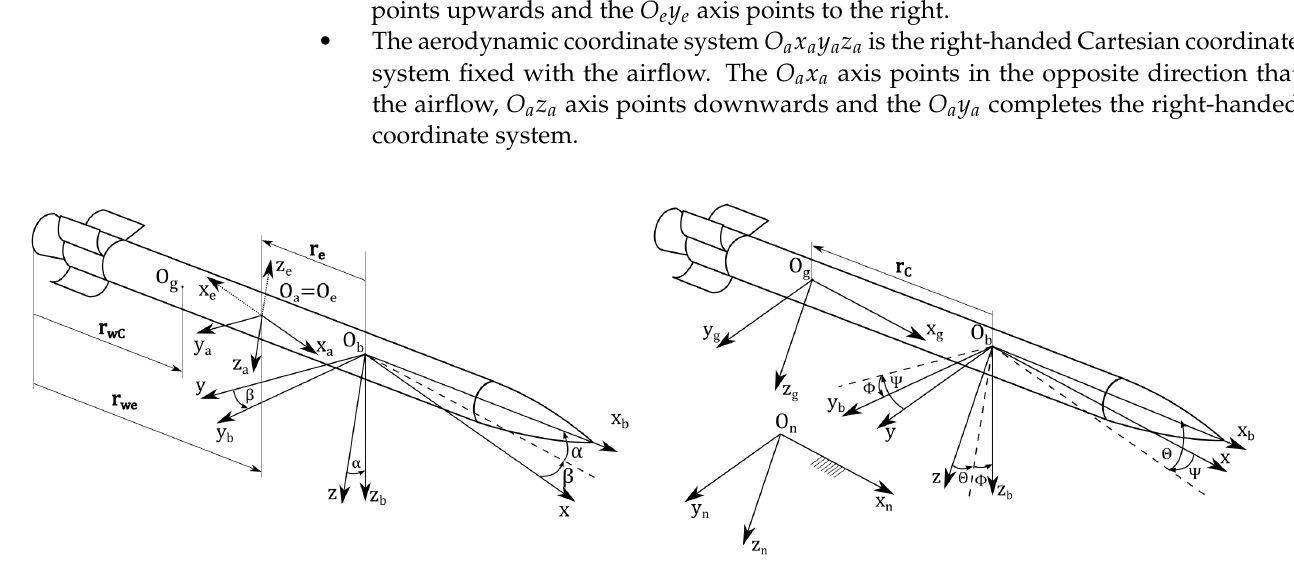
Figure 1. Definition of measuring and aerodynamic coordinate systems, and navigational, gravita- tional and body coordinate